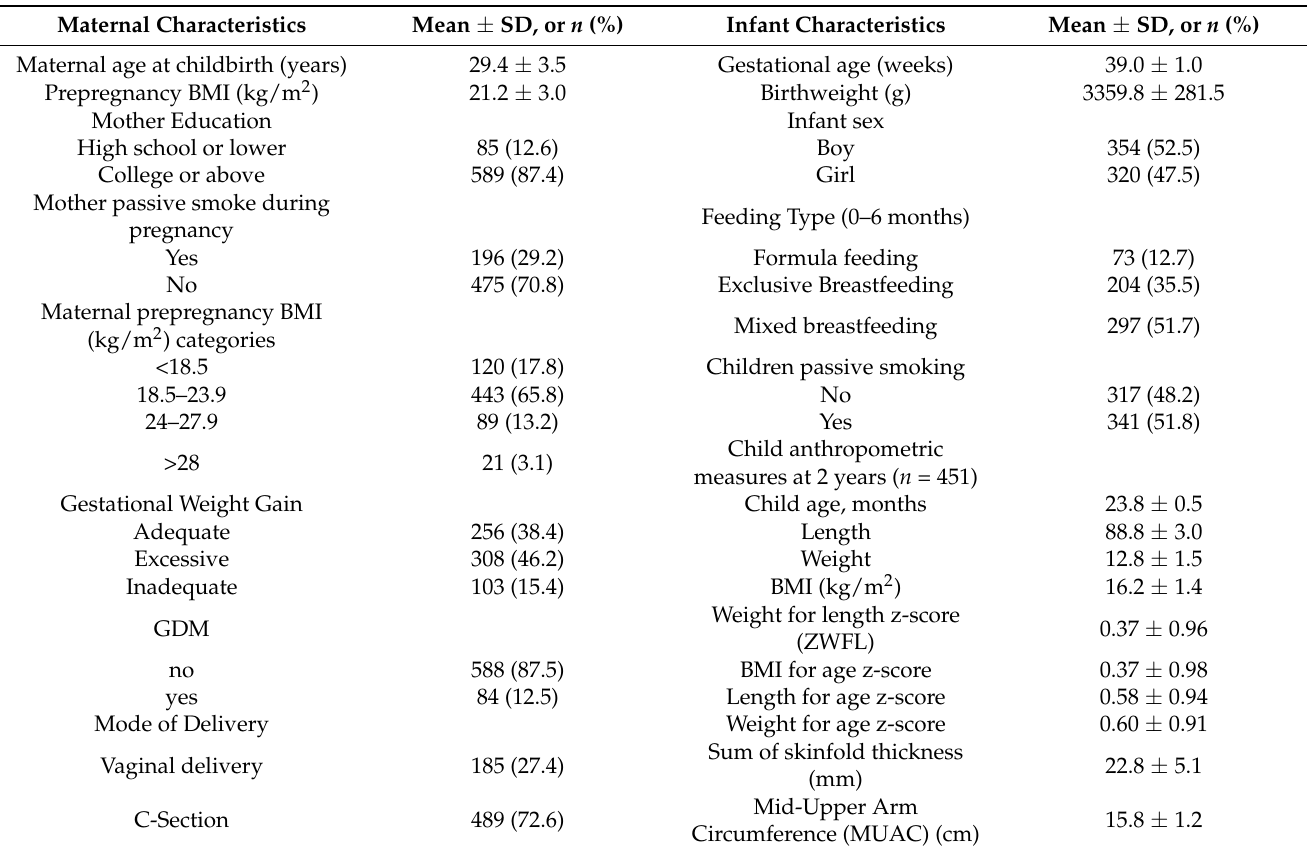
Table 1. Maternal and child characteristics in 674 term-born AGA